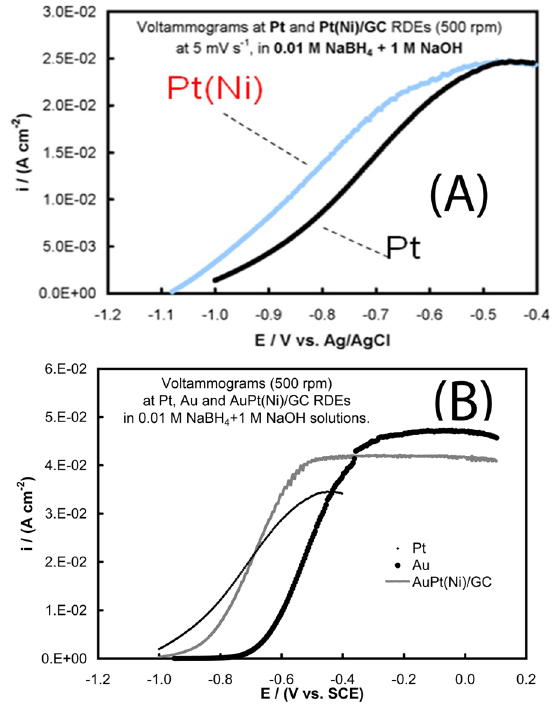
Figure 9. Linear sweep voltamograms (recorded at a 5 mV·s − 1 scan rate) at bi- and tri-metallic layer electrodes, prepared by galvanic replacement, corresponding to borohydride oxidation from 0.01 M NaBH 4 solutions in 1 M NaOH: ( A ) Pt(Ni) and Pt electrodes (Adapted with permission from [106]. Copyright 2011, Elsevier); ( B ) PtAu(Ni), Pt and Au electrodes (Reproduced with permission from [104]. Copyright 2009, Elsevier).